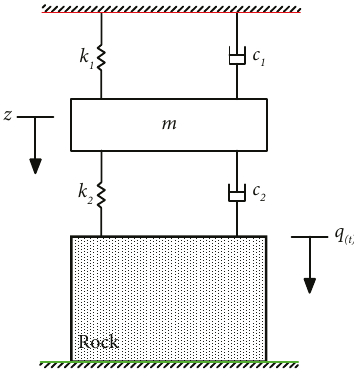
Figure 6: Simplified model of rock breaking by ultrasonic